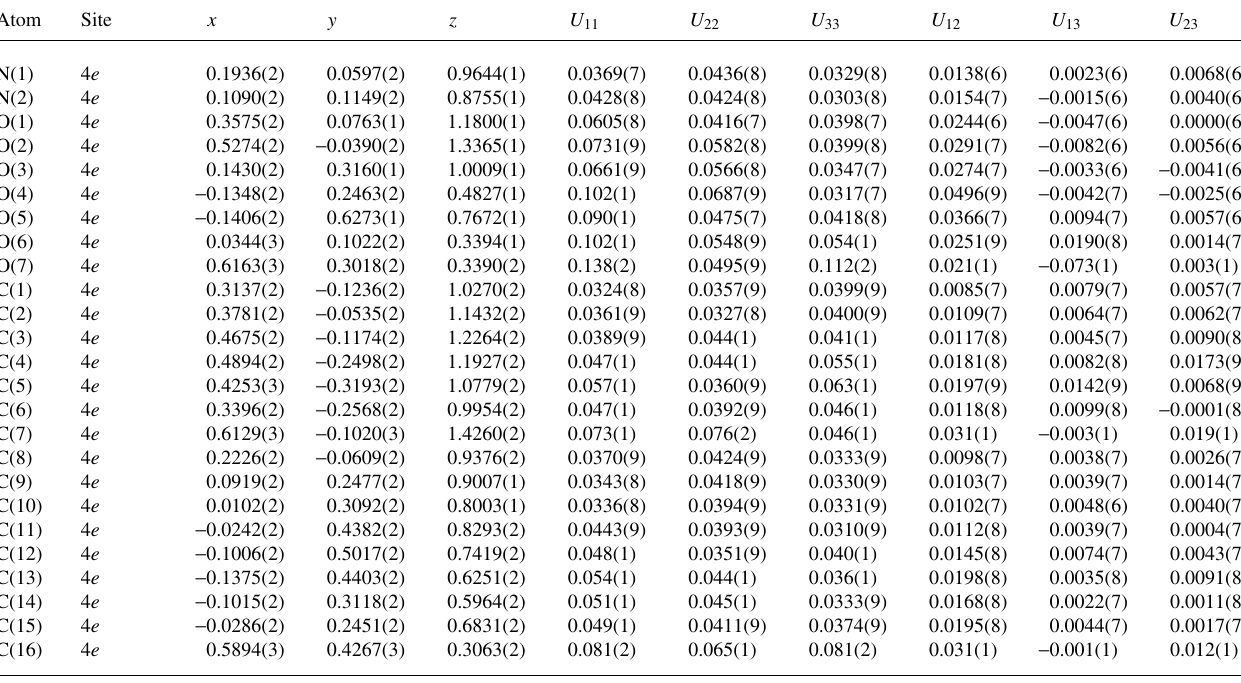
Table 3. Atomic coordinates and displacement parameters (in Å 2 )